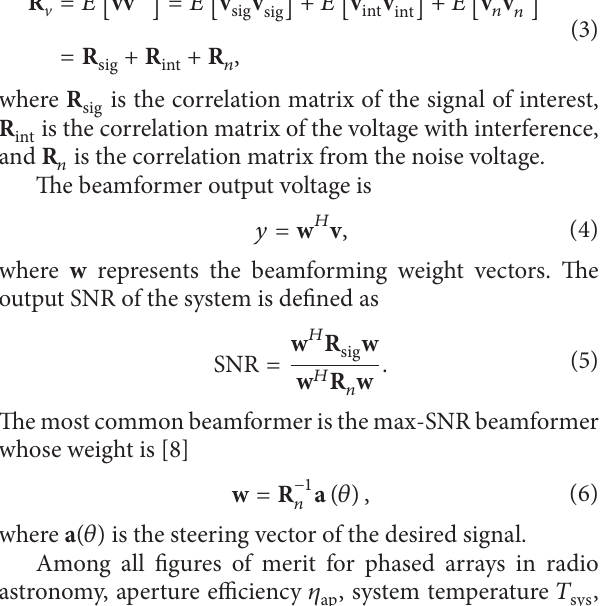
Figure 1: Geometrical structure of the FAST.